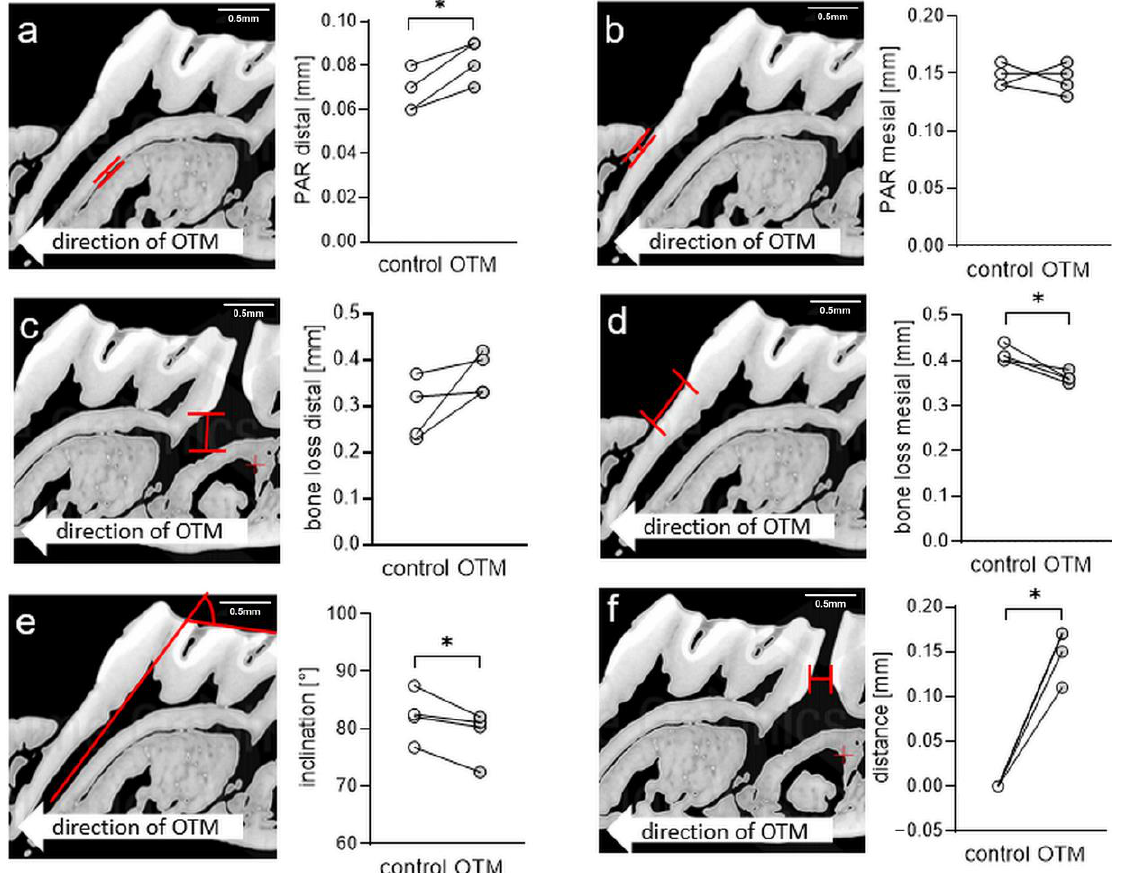
Figure 4. Determination of periodontal gap ( a , b ) and bone loss ( c , d ) distally and mesially of the mesial tooth root of the move upper first molar as well as tooth inclination ( e ) and distance ( f ) between the first and the second molar as an indicator of orthodontic tooth movement ( n = 4). Red line: measured distance or angle. OTM = orthodontic tooth movement. * p < 0.05.